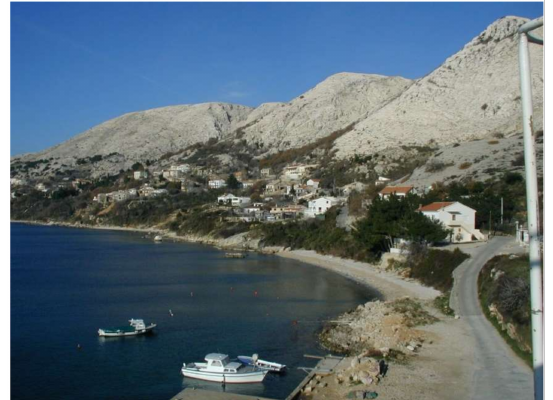
Figure 2. The coastal area near the settlement of Stara